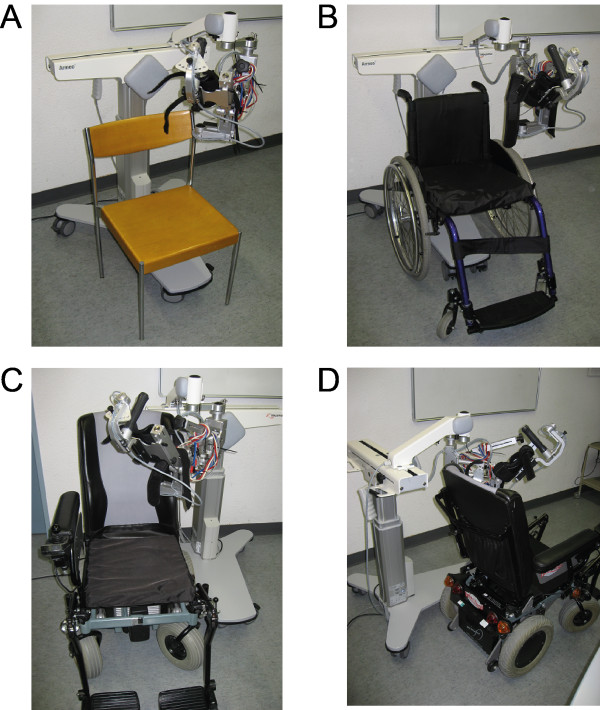
Seating used for movement workspace reliability evaluation between different seating. A: regular wooden chair; B: manual wheelchair used for two conditions: sitting straight, sitting in hip forward position; C: electric wheelchair and D: electric wheelchair with device positioned with a deviation angle of 10° to the wheelchair axe.